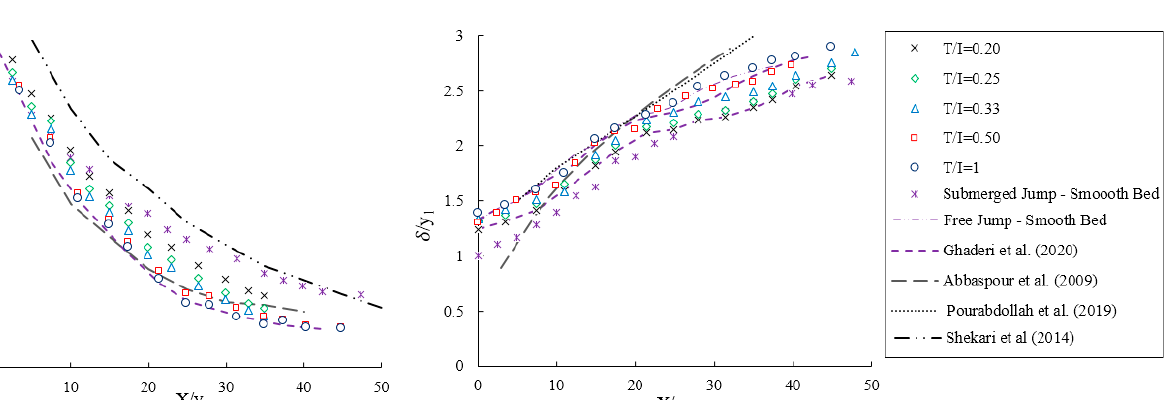
max /u 1 ) and ( δ ⁄y 1